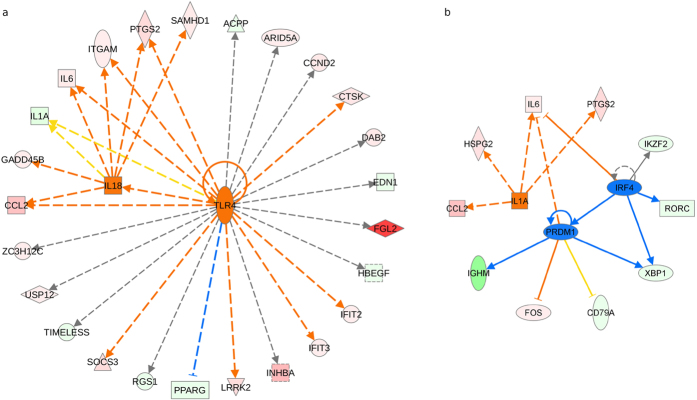
(a) Upstream regulators TLR4 (FC 2.566, z-score = 2.344) and IL18 (FC −4.559, z-score = 2.025) predicted to have enhanced activity in light of the fold changes in the expression of their target genes. (b) Upstream regulators IL1A (FC −5.208, z-score = 1.985), IRF4 (FC −2.188, z-score = −1.969), and PRDM1 (FC −4.254, z-score = −1.698) with a strong trend toward significance, namely with z-scores close to ±2.